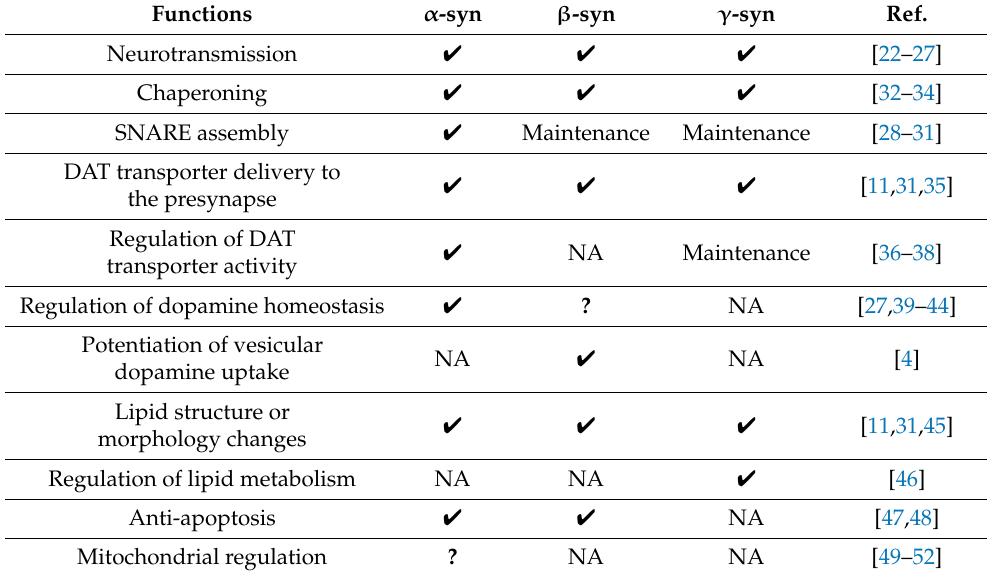
Table 1. Physiological functions of synuclein